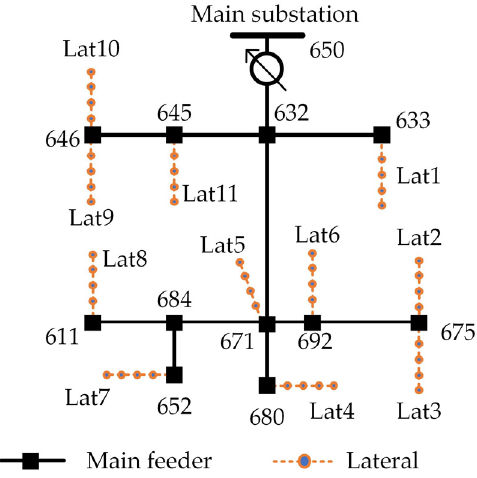
Figure 10. Simulated modified IEEE 13-bus distribution system.